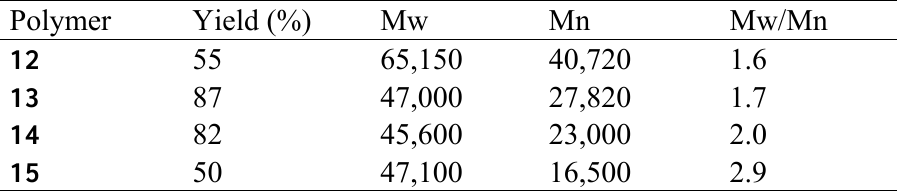
Table 1. Yields, molecular weights and polydispersivities of polymers 12 - 15